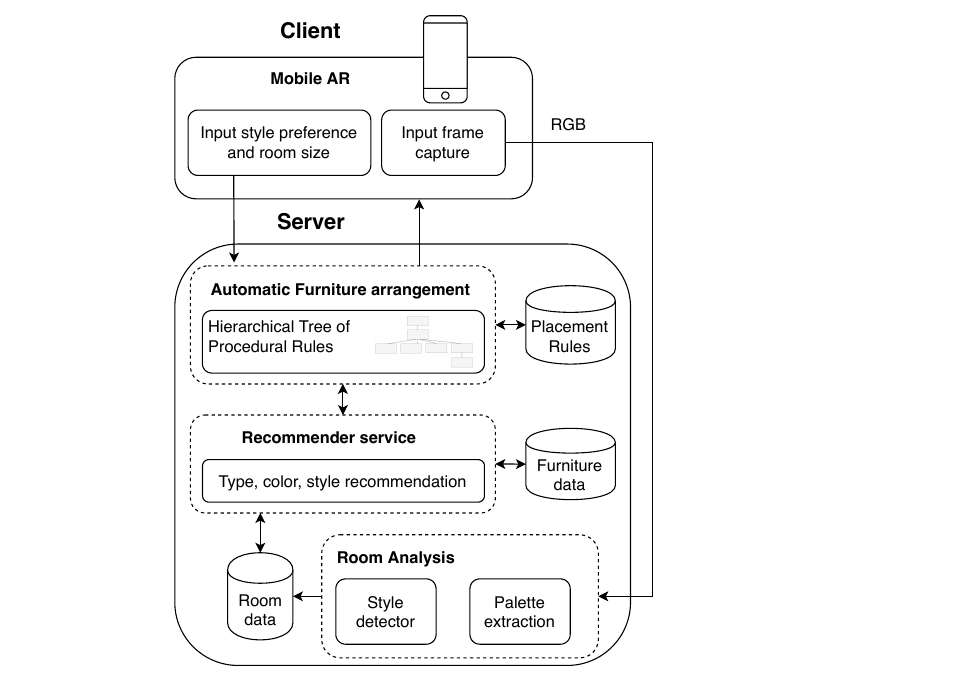
Figure 1. Schematic diagram of our system for interior design in augmented reality (AR). The server generates interior design for the user with the help of the recommender and room analysis services. This design is then visualized in AR in the client application. We use the database of procedural rules for layout generation and database of furniture data for personalized recommendation. Pictures of real scene, captured by a mobile device, are analyzed in our room analysis service to identify styles and colors of the room and aid the recommendation. We utilized Representational State Transfer (REST) architecture to design the services of our system and communication between